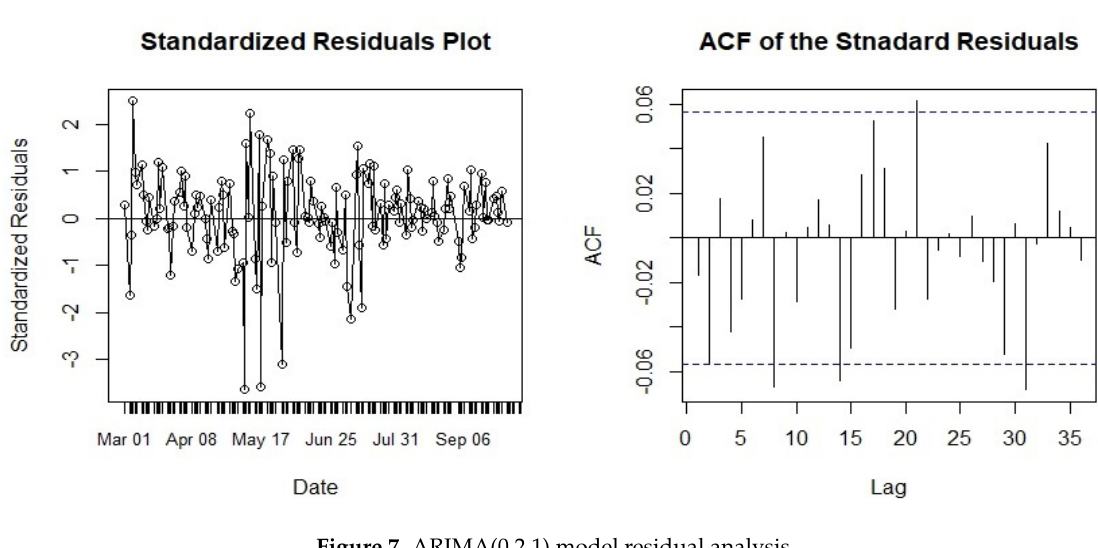
Figure 7. ARIMA(0,2,1) model residual